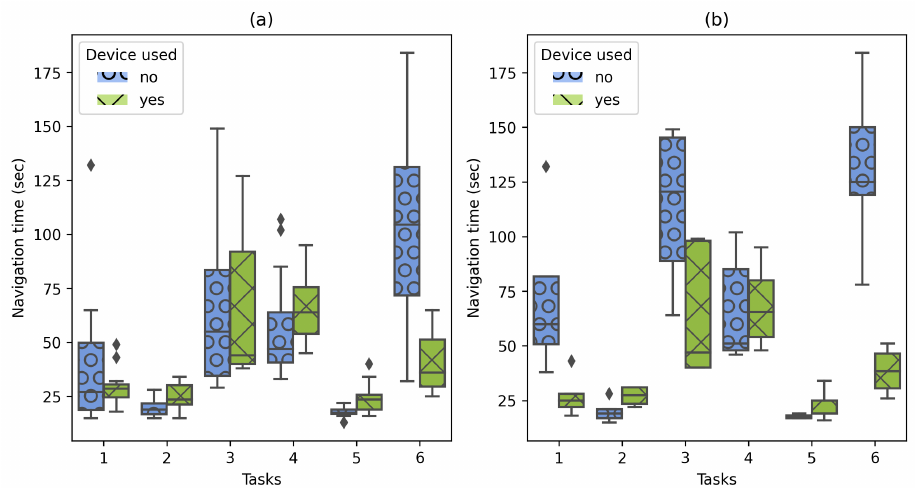
Figure 7. Navigation time recorded with and without the use of the implemented system. ( a ) Time recorded for all cases (144 cases). ( b ) Time recorded in the cases where users were not familiar with the navigation environment (54 cases).